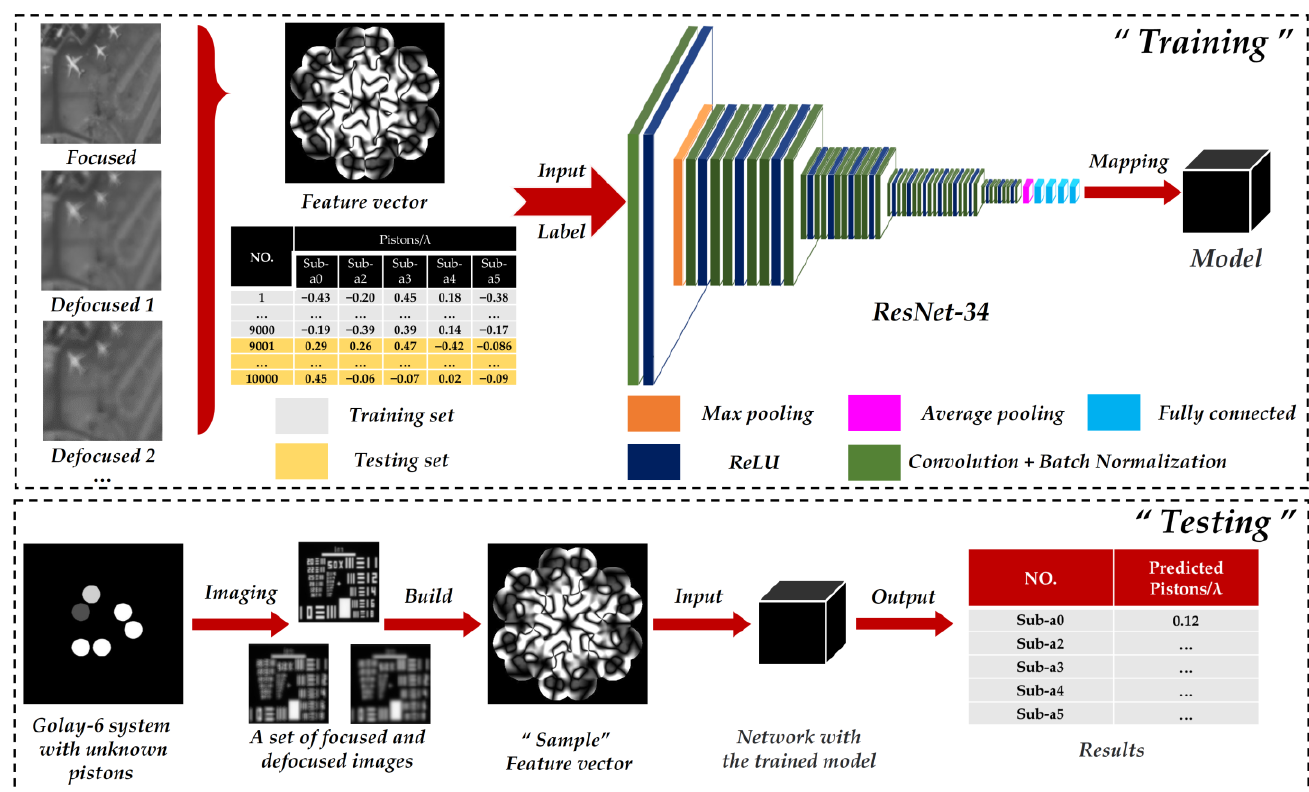
Figure 3. The principle of the piston sensing method based on ResNet-34, including the detailed process of “Training” and “Testing” procedures. Table 2. Experimental